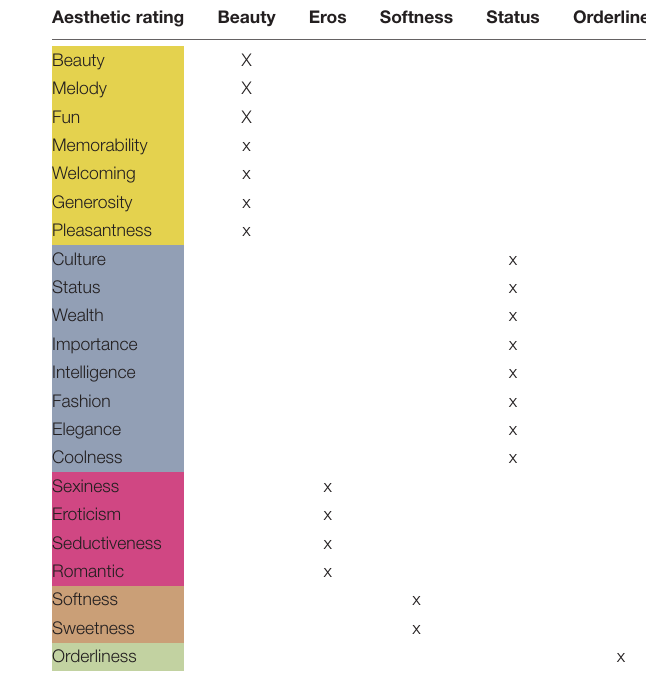
TABLE 4 | The 22 aesthetic ratings collapsed into five factors (Beauty-yellow, Status-blue, Eros-red, Softness-orange, and